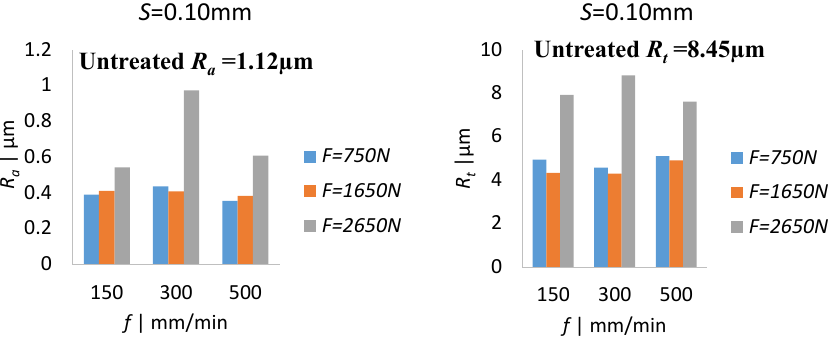
Figure 8. Effect of burnishing force and feed on roughness— R a ( left ) and R t ( right )—at a step-over, with an S of 0.10 mm.